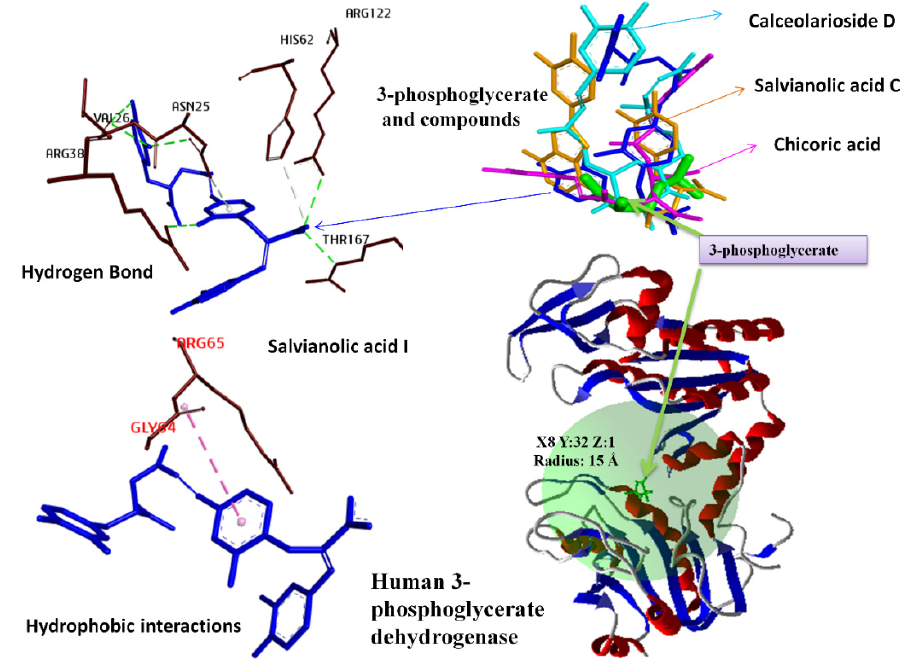
Figure 2. Binding cavities and their details for each molecular docking simulation .